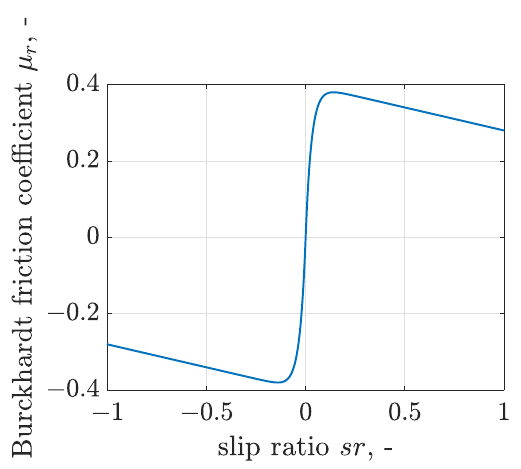
Figure 4. Characteristics of tire to road friction force on slip ratio for the Burckhardt model and wet concrete